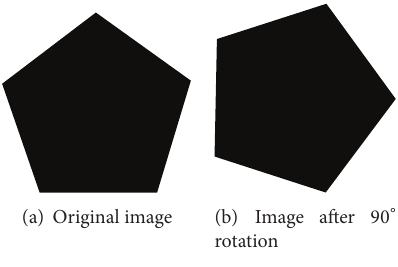
Figure 1: Image of